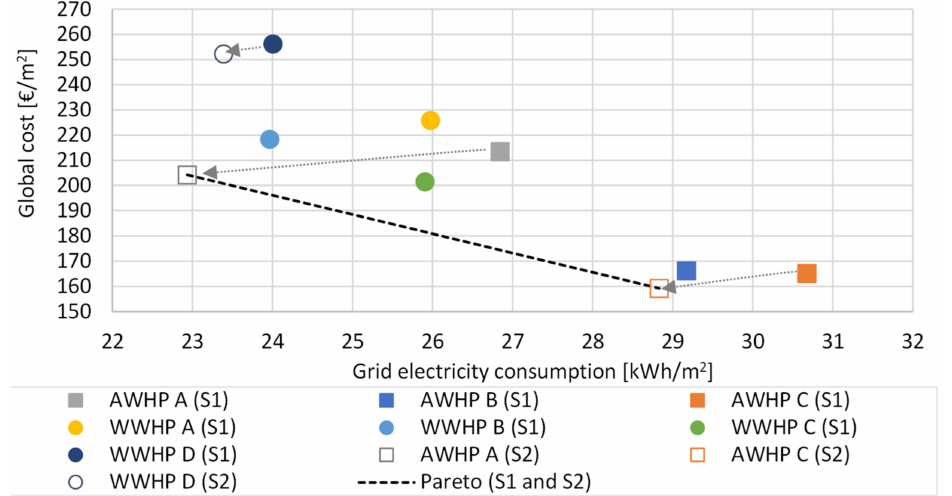
Figure 11. Results of global cost and grid electricity consumption from simulations for AWHP and WWHP systems with PV collectors covering the non-renewable part of the electricity for cases with neglected PLF (scenario 1) and the manufacturer-provided PLF (scenario